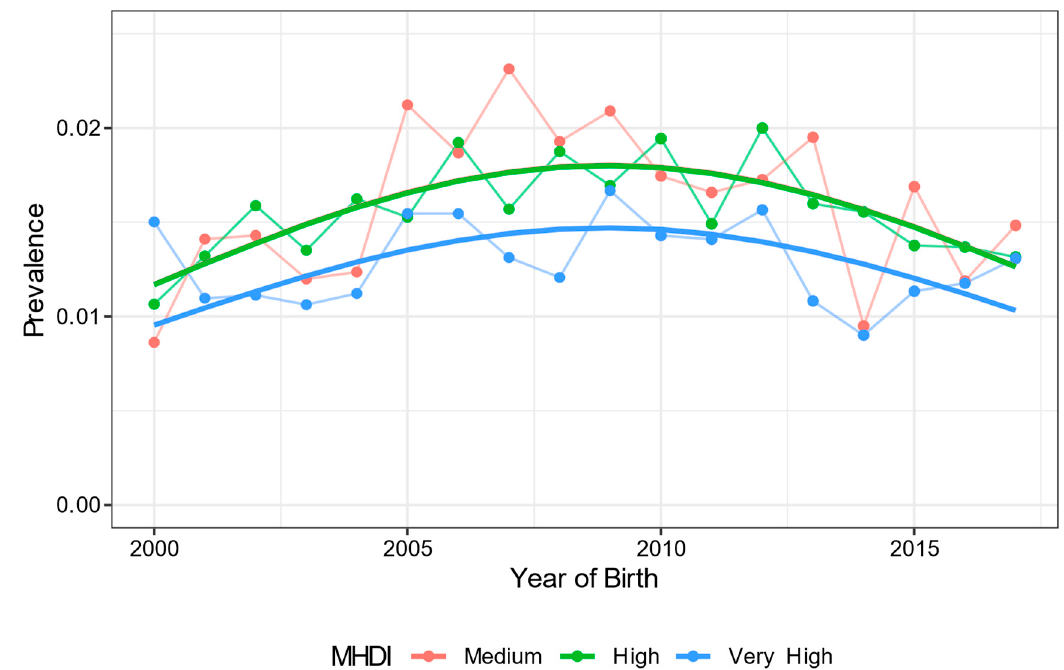
Figure 2. Prevalence of congenital anomaly per year among newborns according to the local development (MHDI classification) in the city of Porto Alegre, Rio Grande do Sul, from 2000 to 2017. Numerator: total number of newborns identified with CA. Denominator: total live births in the same year.